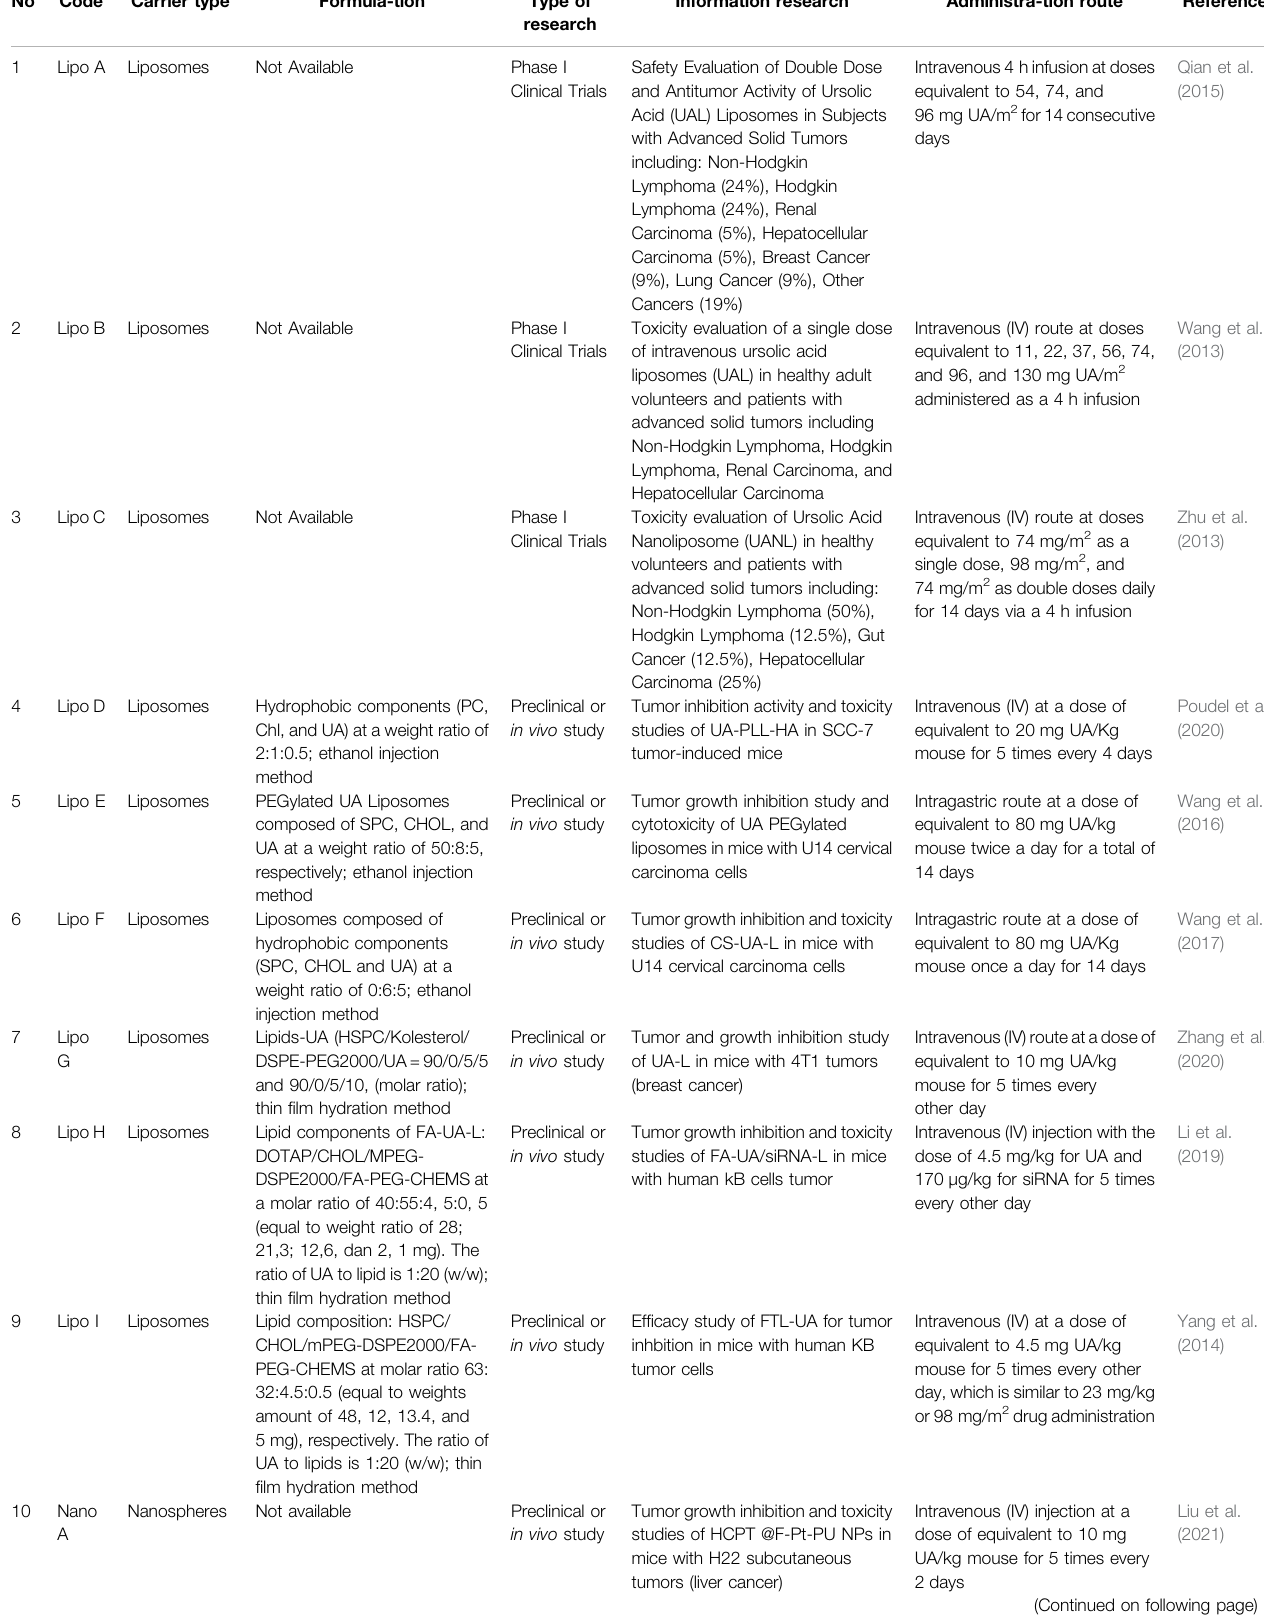
TABLE 2 | The summary of literature reviews for UA-loaded